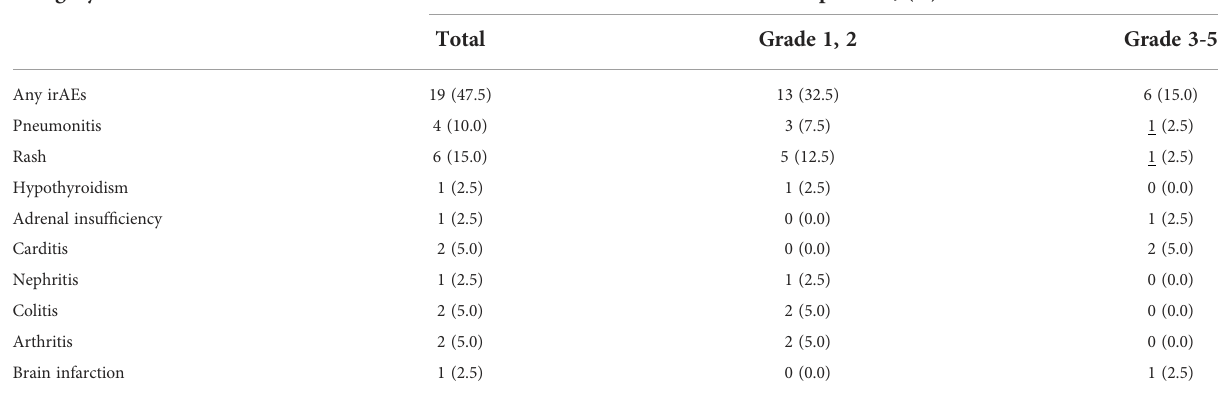
TABLE 3 Adverse events and immune-related adverse events in all NSCLC patients.